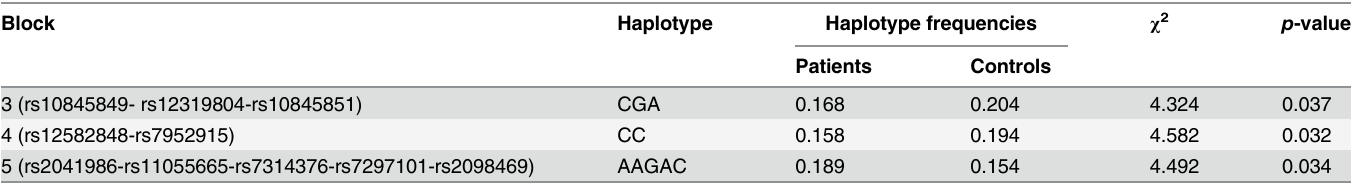
Table 2. Frequencies of three schizophrenia associated haplotypes in SZ patients and controls.